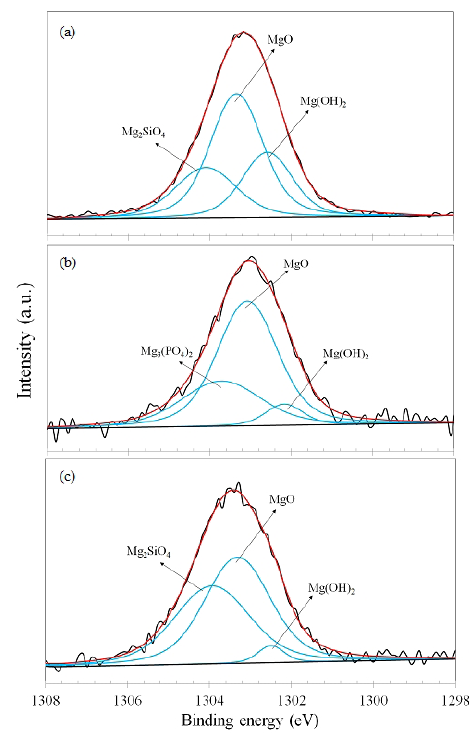
Figure 6. XPS Mg 1s high resolution spectra: a) SI-20; b) PHO-20; c) BO-20.